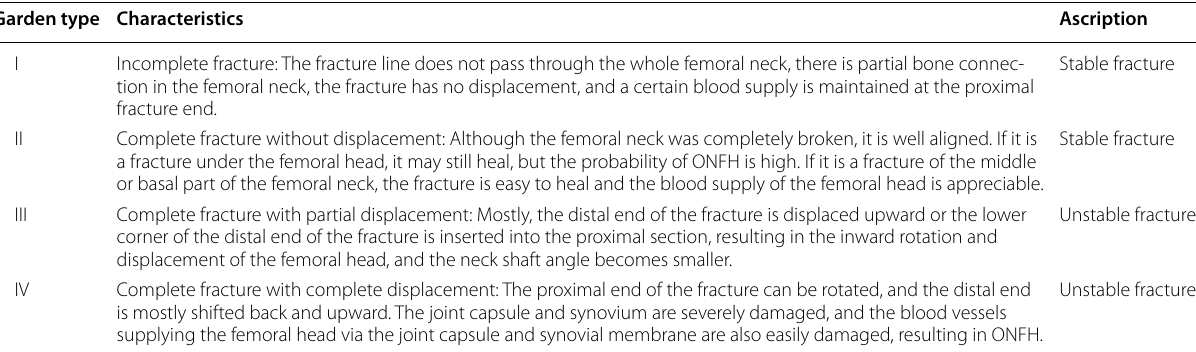
ONFH , osteonecrosis of femoral head